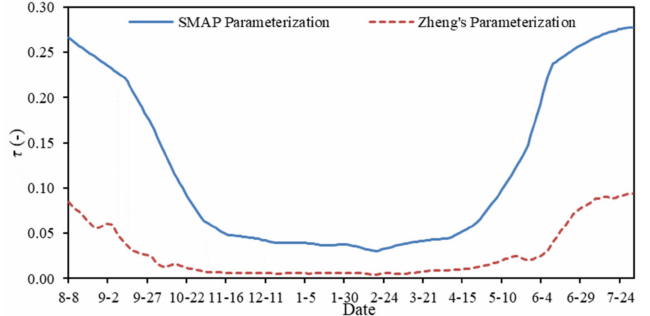
Figure 2. Time series of τ estimates derived from SMAP and Zheng’s parameterizations between August 2016 and July 2017 for the SMAP descending